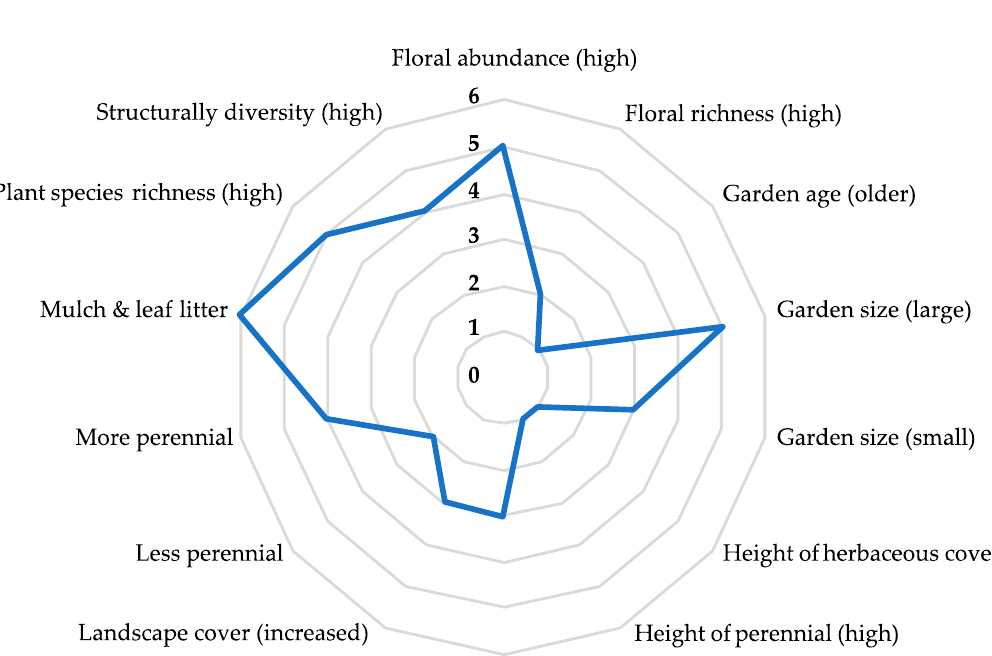
Figure 2. Numbers along the center y-axis represent the number of reportable results in the reviewed literature that indicate a positive effect to natural enemy richness, abundance, and rates of biological control. Reported results are correlated with explanatory variables (local factors) listed on the exterior of the radar chart.